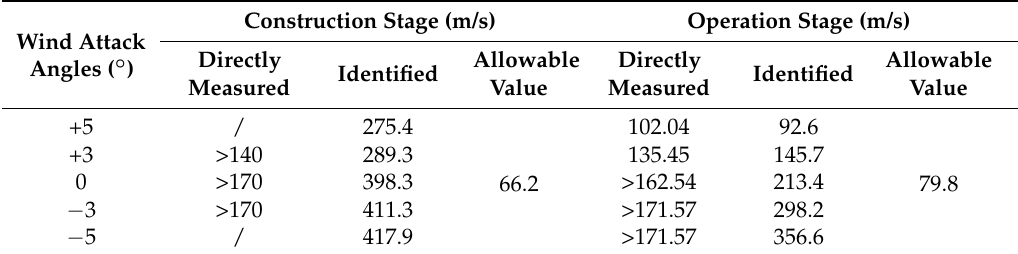
Table 2. The critical flutter wind speeds of the test